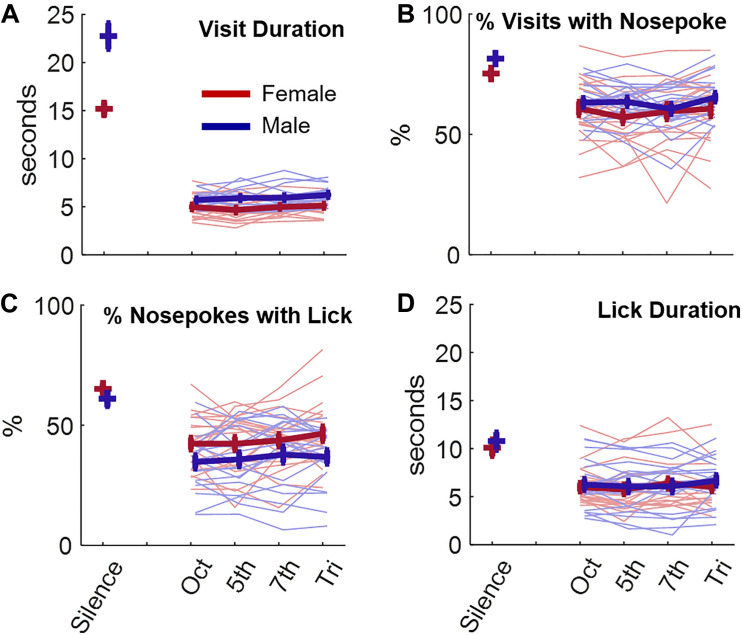
Effects of listening to consonant or dissonant chords on behavior. (A) Visit duration in seconds as a function of the chord presented or during silence. The behavior of female (red) and male (blue) animals is displayed. Thin lines are individual data while thick lines display average +/– standard error bars. (B–D) Same as (A) for the percentage of nosepoking during each visit (B), for the percentage of licking during each nosepoke (C), and for the lick duration (D).